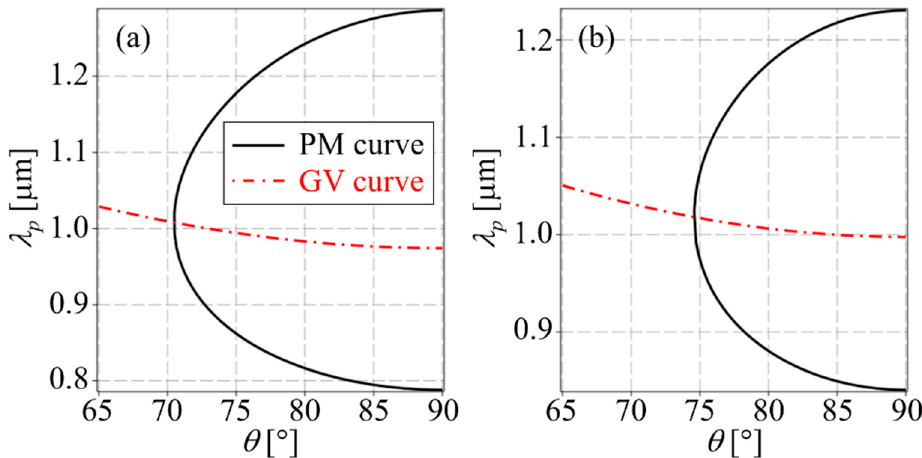
Figure 4. Numerical simulation results of Type II EPM in ( a ) a LN and ( b ) a 5-mol% MgO:LN. In each graph, the intersection point of the PM and GV curves represent the k p -direction (i.e., θ ) and the corresponding λ p satisfying Type II EPM. Table 2. Type II EPM properties of two kinds of non-poled LNs: the PM direction ( θ ), the resonant pump wavelength ( λ p ) and the corresponding signal/idler wavelengths, ( λ s,i ), the effective nonlinear optic coefficients ( d eff ), the angle of walk-off between the interacting photons ( w ), and the beam deviation ( Δ ).